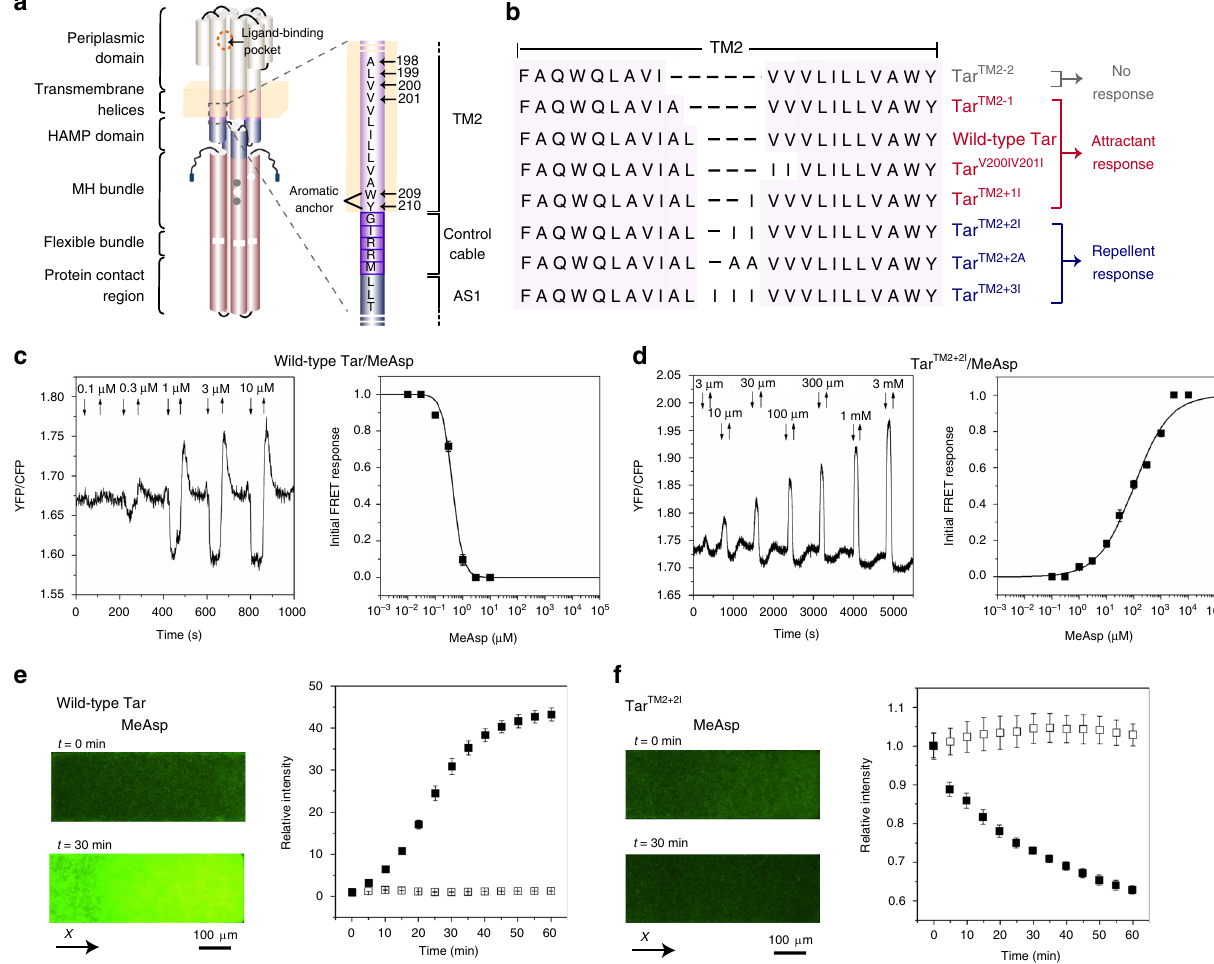
Fig. 1 Effects of mutations in TM2 on Tar response to MeAsp. a Schematic representation of E. coli Tar receptor. b Sequence alignment for the wild-type and mutant Tar. Different colors indicate receptors that mediate attractant, repellent, or no responses to MeAsp, respectively. c , d FRET responses of E. coli CheR + CheB + strain VS181, expressing the wild-type Tar ( c ) or Tar TM2 + 2I ( d ) as a sole receptor, as well as the FRET pair, to a stepwise addition (down arrow) and subsequent removal (up arrow) of the indicated concentrations of MeAsp. The corresponding amplitudes of initial FRET responses were plotted as a function of step changes in concentration of MeAsp. The data were normalized to the saturated response. Error bars indicate standard deviation of three independent biological replicates; note that for most data points error bars are smaller than the symbol size. e , f Micro fl uidic assay of the chemotactic response of receptorless strain UU1250 expressing wild-type Tar ( e ) and Tar TM2 + 2I ( f ) to MeAsp. Cell distribution in the observation channel was recorded when the source is 10 mM MeAsp or without MeAsp (scale bar, 100 μ m). The x -component (black arrow) indicates the direction up the concentration gradient of MeAsp. Relative cell density ( fl uorescence intensity) in the observation channel for the wild-type Tar ( e ) or Tar TM2 + 2I ( f ) responding to MeAsp (closed squares) or without MeAsp (open squares) were plotted over time. The cell density in the observation channel before MeAsp stimulating ( t = 0) was normalized to be one. Error bars indicate standard deviation of three independent biological